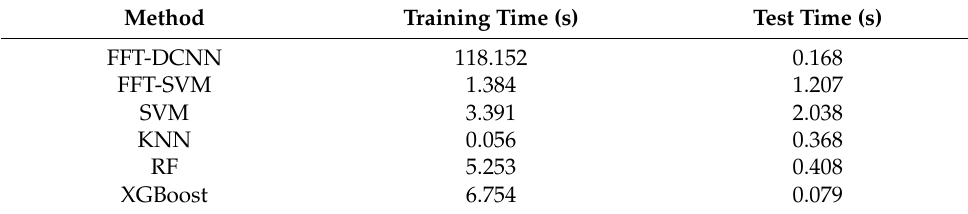
Figure 14. Comparison of test time between the proposed method and ML algorithms. Table 6. Comparison of cost time between the proposed method and ML